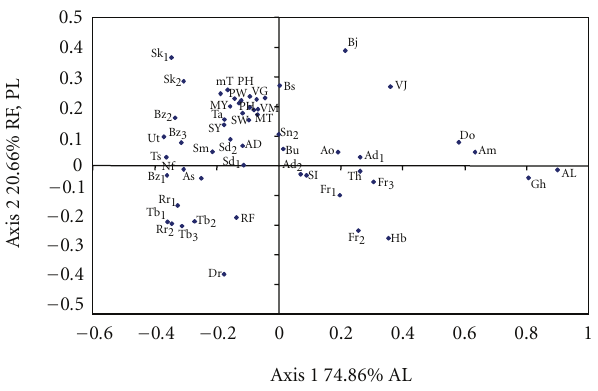
Figure 3: Dispersion of populations in the 1-2 plan of the facto- rial correspondence analysis based on agronomic characters and pedoclimatic factors. Populations and parameters abbreviations are summarized in Tables 1 and 2,